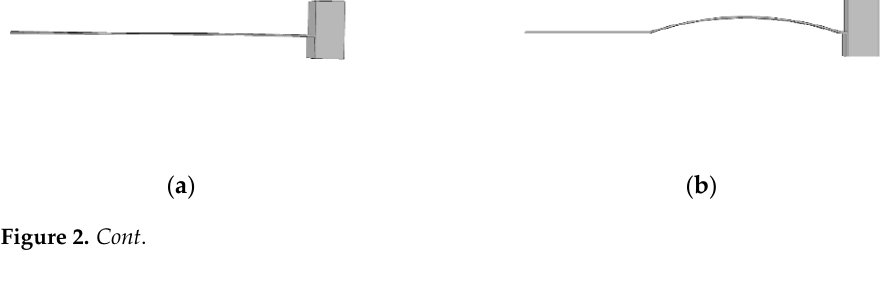
Table 1. Material parameters for simulation.